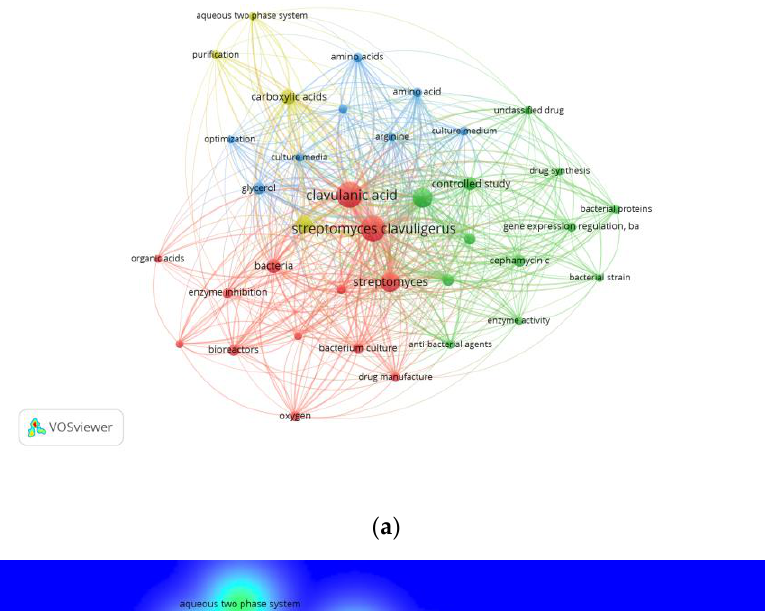
Table 3. Subject areas of studies on CA production by S. clavuligerus in the chemical engineering discipline between 1976 and 2017.